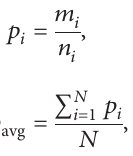
Figure 4: The sliding process of the